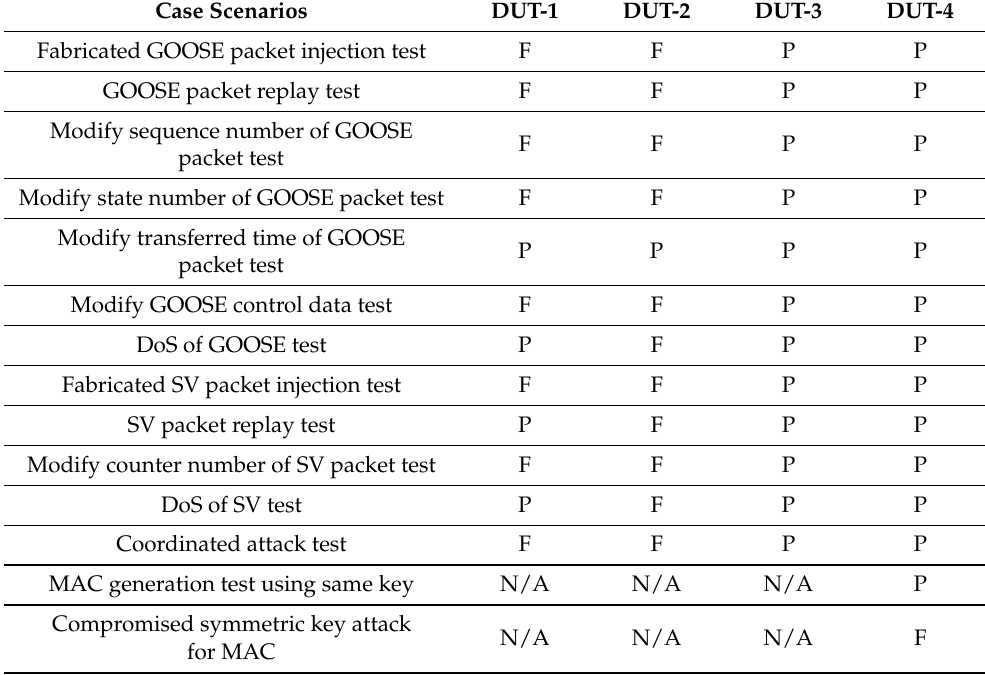
Figure 6. Diagram of cybersecurity testing module. Table 1. The results of the case scenarios, (P: PASSED, F: